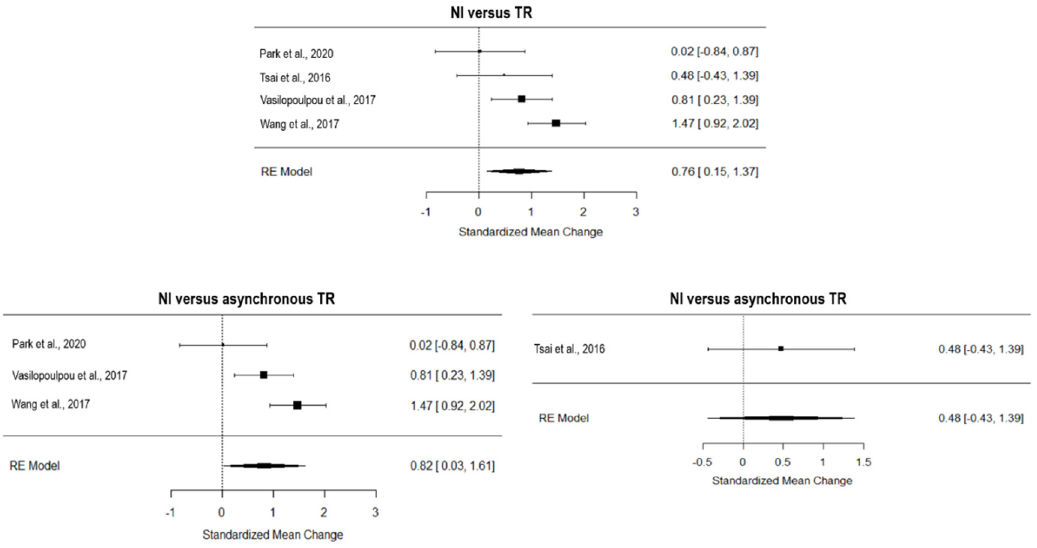
Figure 4. Forest plot of the effect of TR on dyspnea compared to usual care. TR, TR; NI, no interven- tion [8,33,35,41]. Ref. [31] has not been included in the analysis based on the leave-one-out analysis.